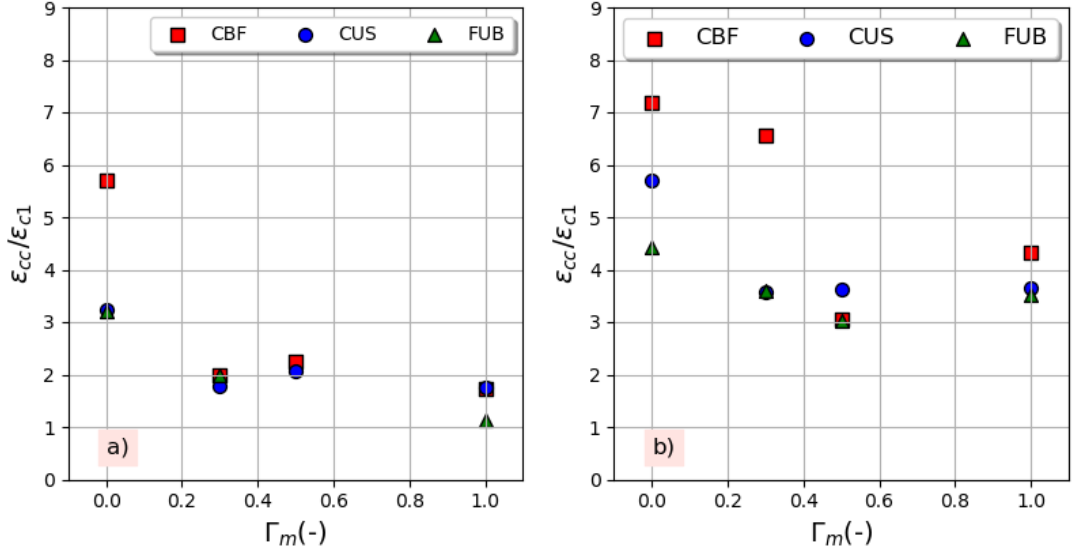
Figure 9. Strain efficiency with replacement ratio: ( a ) without air-entraining agent, ( b ) with 4% air-entraining agent.